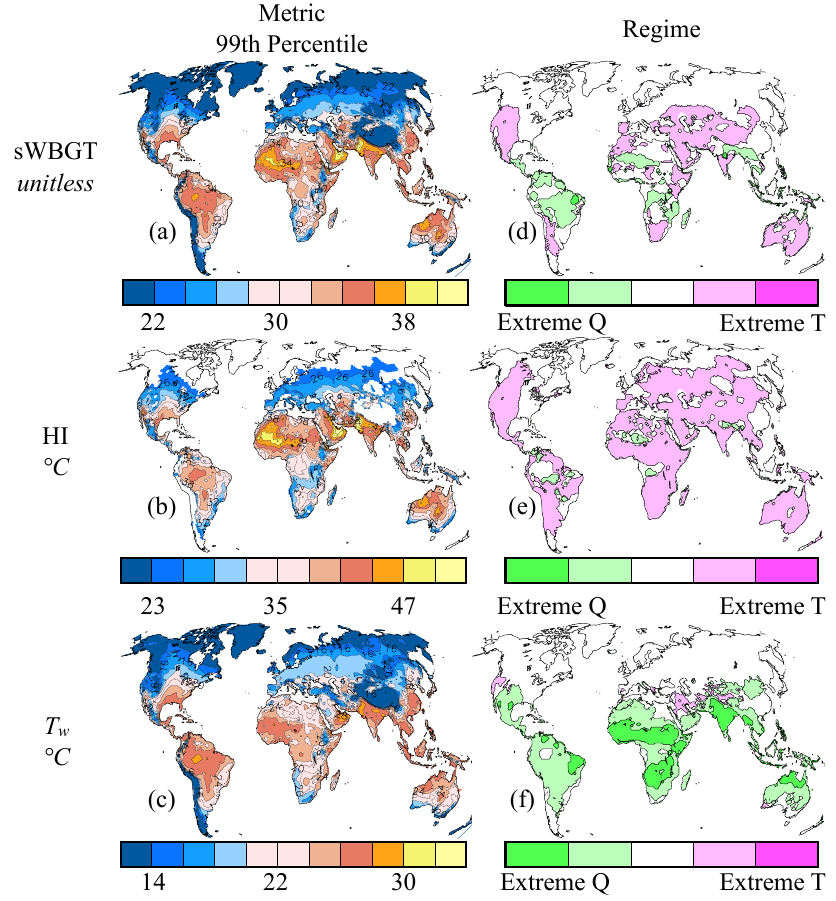
Figure 5. 99th percentile exceedance value of three metrics for (a) sWBGT, (b) HI, and (c) T w (left). Expected rank value T − Q regime maps (d) , (e) , and (f) (right) conditioned by (a) , (b) and (c) , respectively. Rank values for (d) – (f) are described in Fig. 2.